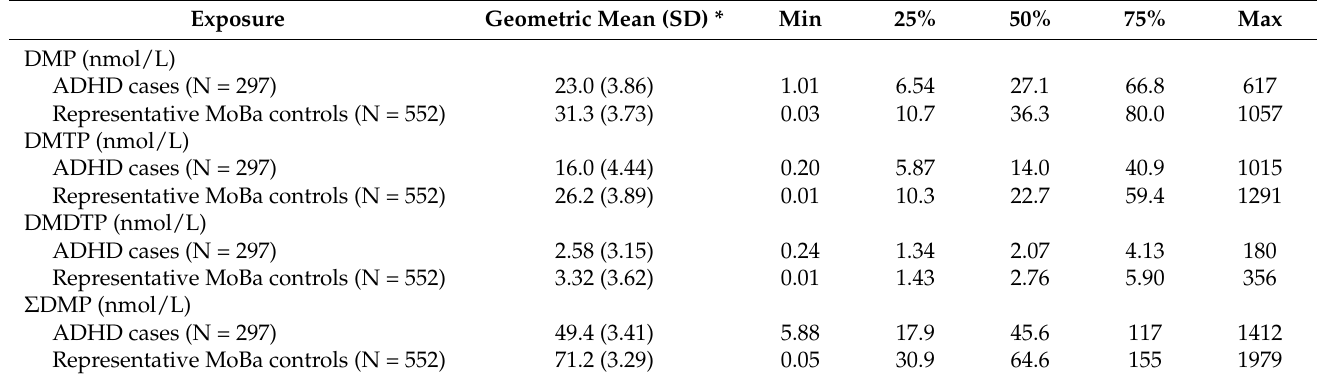
Table 2. Specific-gravity-corrected organophosphorus metabolite distribution at 17 weeks’ gestation in a nested case-control study of attention-deficit/hyperactivity (ADHD) in the Norwegian